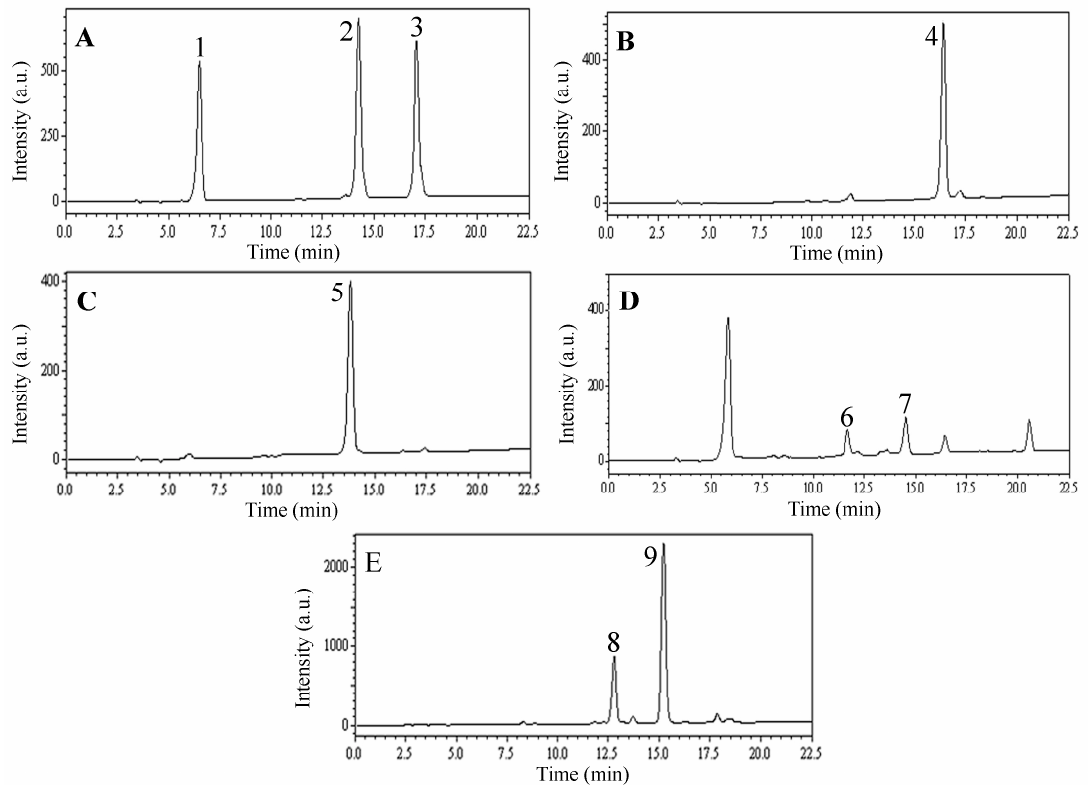
Figure 4. HPLC chromatograms of n -butanol extract and HSCCC peak fractions from leaves of L. japonica . ( A : F1 in Figure 3; B : F2 in Figure 3; C : F3 in Figure 3; D : F4 in Figure 3; E : F5 collected from the column after the separation). Experimental conditions: Shim-pack VP-ODS column (250 mm × 4.6 mm, i.d., 5 µm); Column temperature: 25°C; Flow rate: 1.0 mL/min; Detection: 254 nm; Injection volume: 10 µL. HPLC conditions are as follows: Eluent A (MeOH) and eluent B (0.3% acetic acid in water, v/v ), linear gradient combinations: at t = 0, 70% B; at t = 20 min, 40% B; at t = 22.5 min, 40% B. a.u.: arbitrary unit. Table 3. Processing conditions for the preparative HPLC separations of sub-fractions F1, F4 and F5.